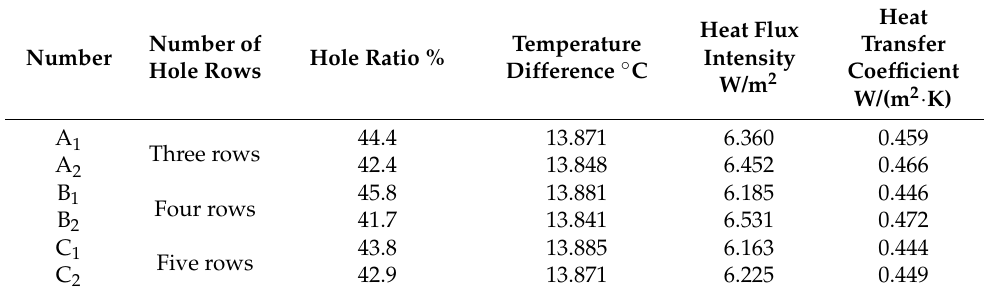
Table 5. Simulated thermal